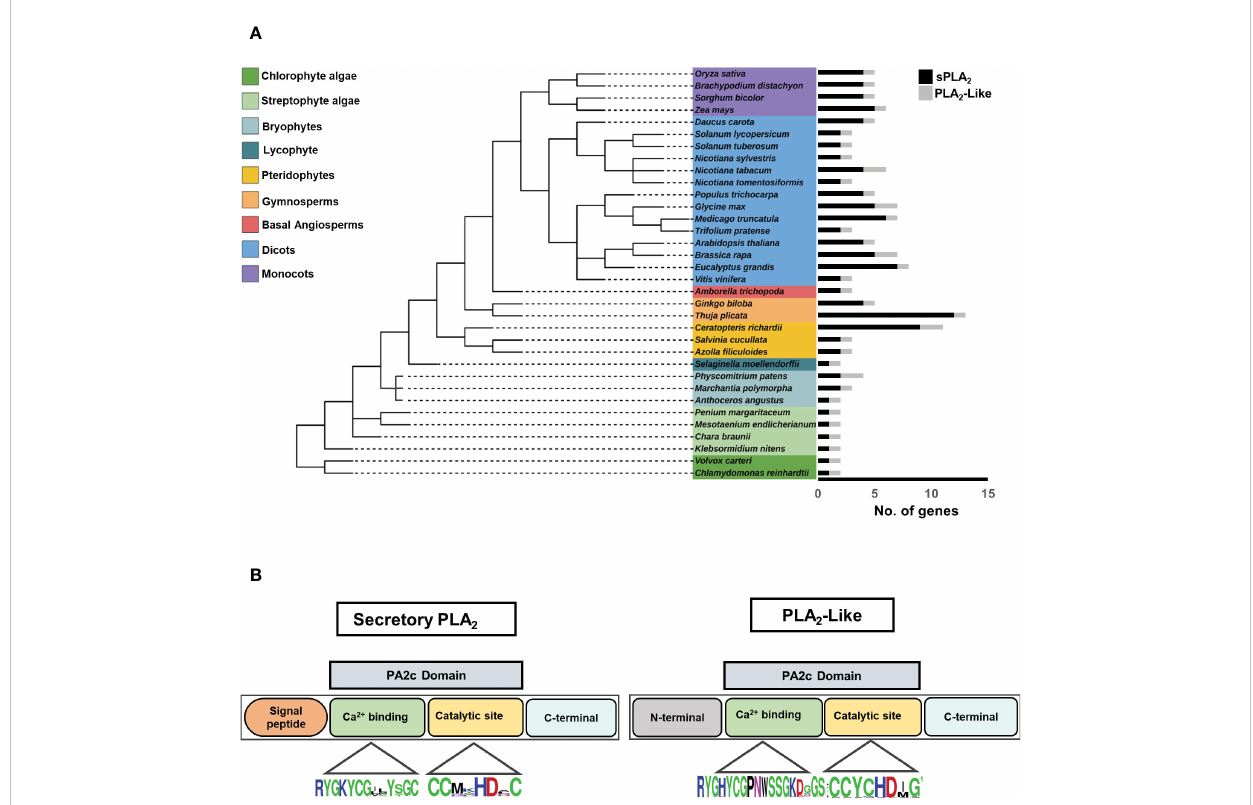
FIGURE 1 (A) Distribution of secretory PLA 2 and PLA 2 -like genes in the different plant taxonomic groups, including Algae, Bryophytes, Pteridophytes, Gymnosperms, and Angiosperms. The species tree was elucidated using the NCBI taxonomy database and edited in the Interactive Tree of Life (iTOL) web tool. Each histogram corresponds to the number of sPLA 2 and PLA 2 -like in each species. Black, histogram-sPLA 2 ; Gray, histogram-PLA2- like genes. (B) Schematic representation of PLA 2 protein with N and C terminal, conserved PA2c domain, Ca 2+ binding motif, and HD catalytic